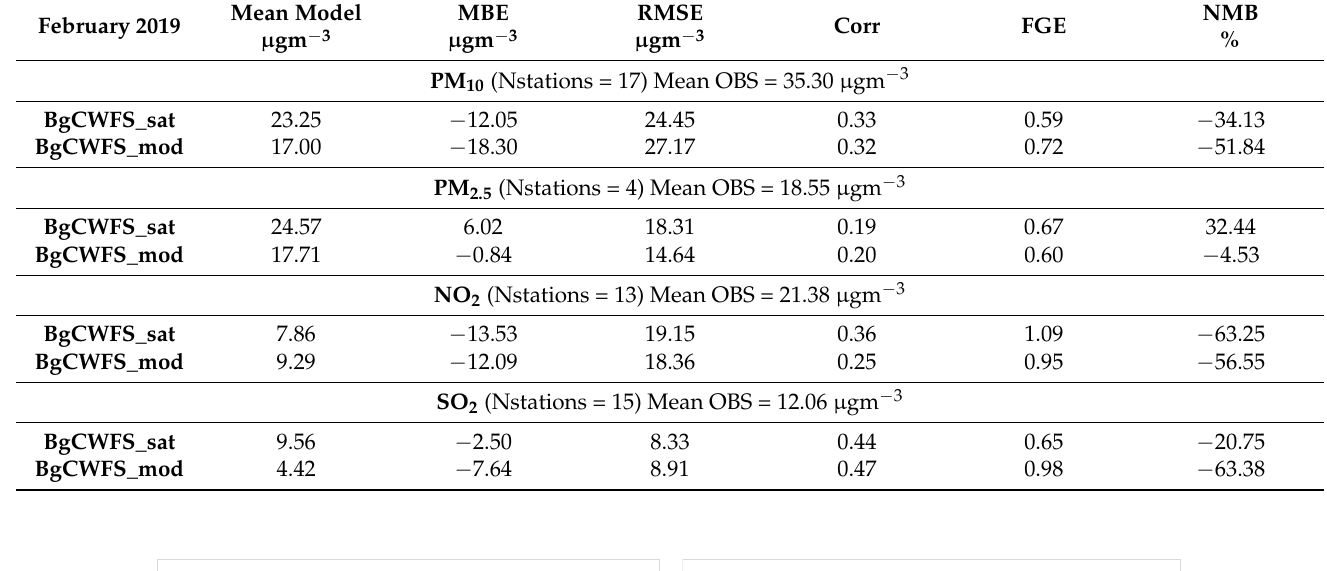
Table 2. Statistical parameters for BgCWFS results compared to surface observations in February 2019.